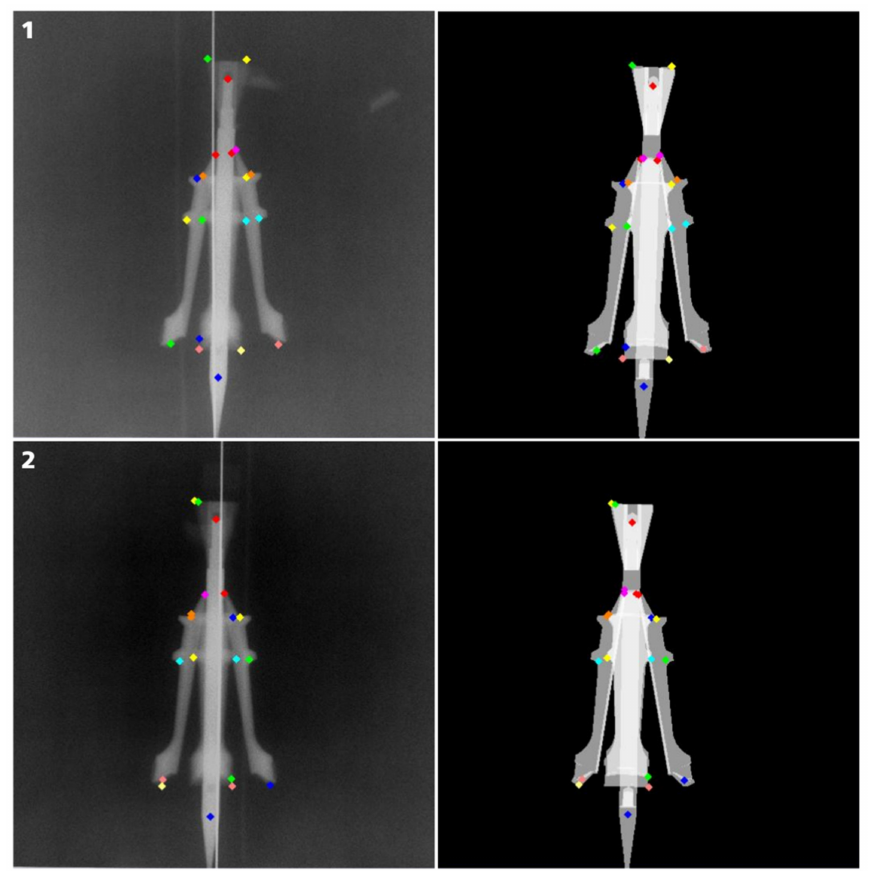
Figure 3. Example of the software-based X-ray analysis. On the left side, the X-ray images, including the set of tagged feature points, are displayed for one position (point in time) and two corresponding perspectives (1, vertical view; 2, horizontal view). The resulting positioning of the models is shown as a simulated X-ray image on the right